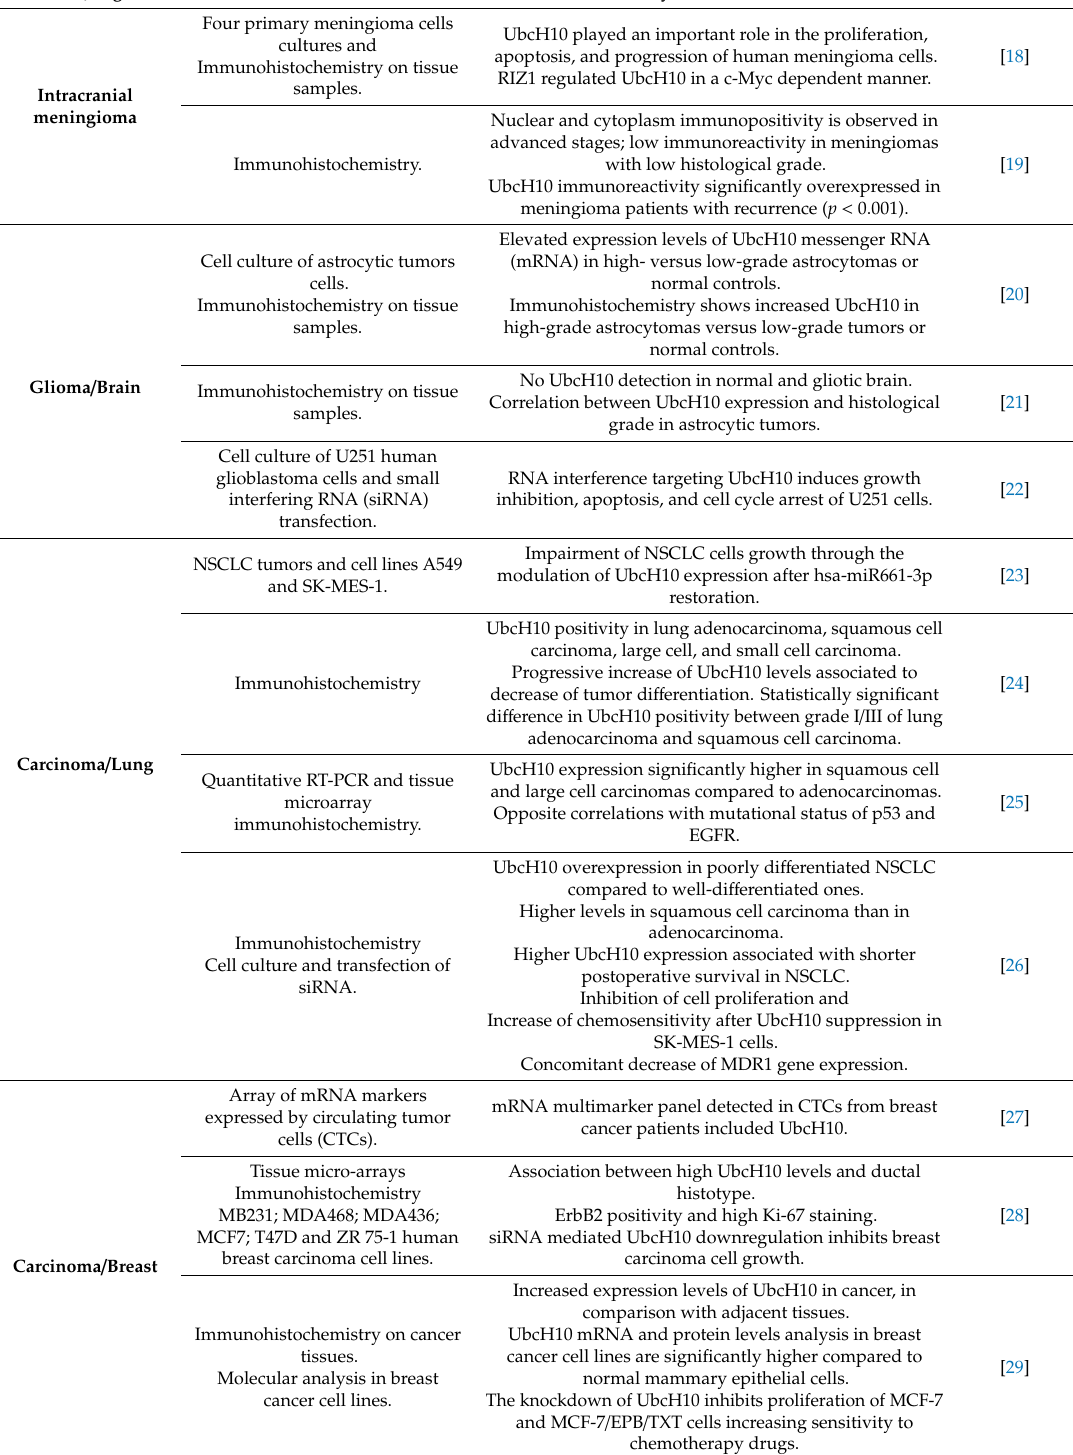
Table 1. List of significative papers about the role of UbcH10 in various